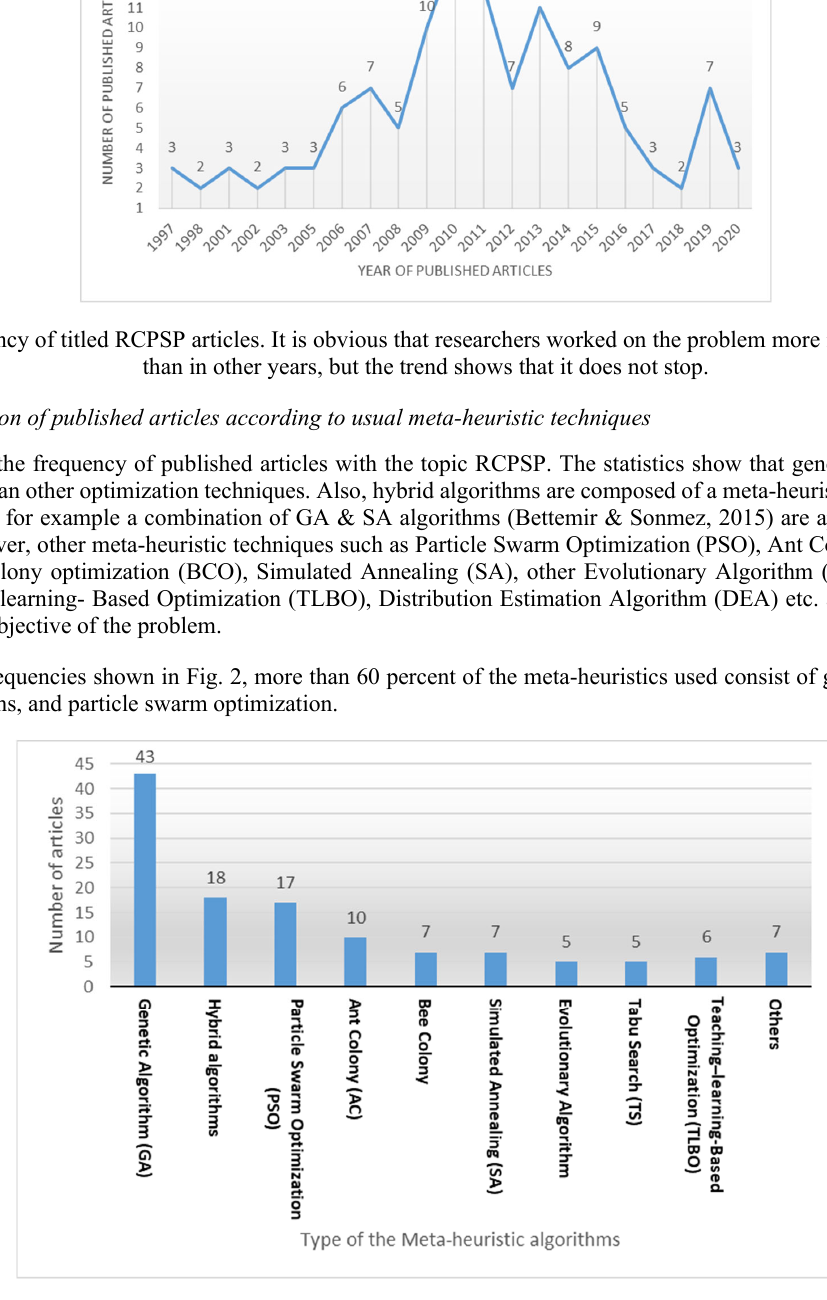
Fig. 2 . Classified RCPSP articles according to the meta-heuristics. The three most popular solution techniques are genetic algorithms, hybrid algorithms, and particle swarm